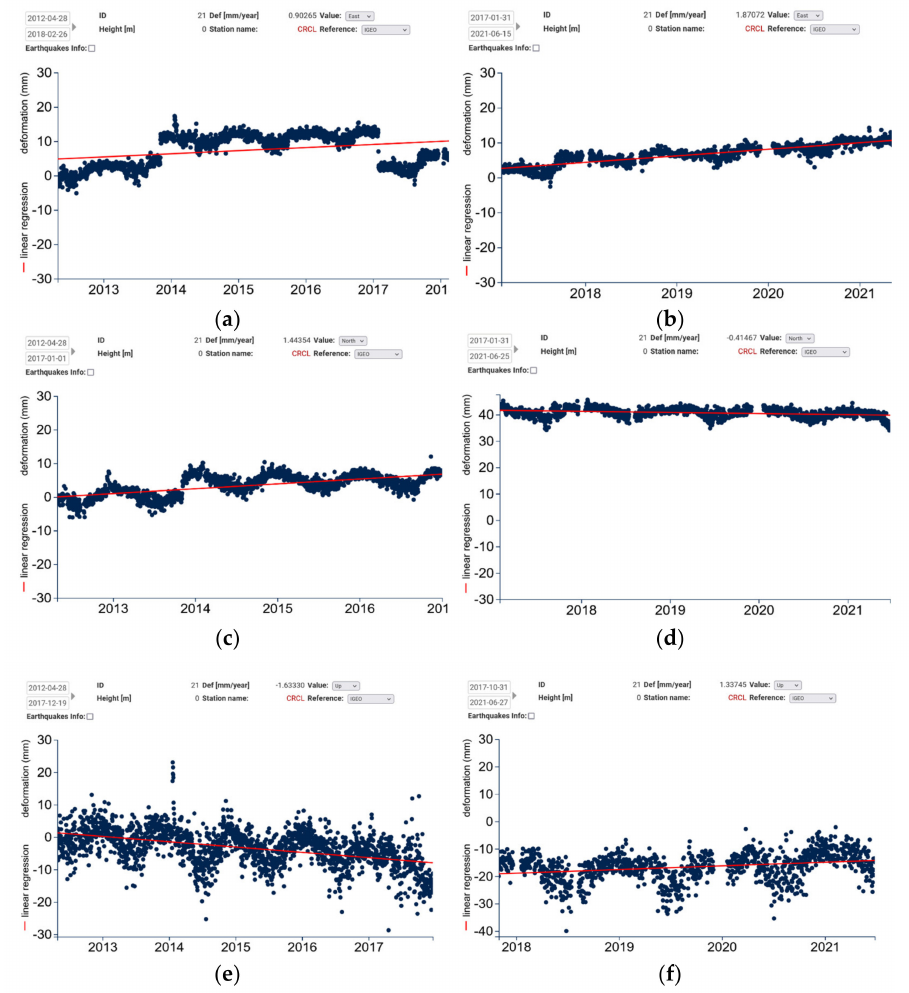
Figure 21. GNSS measured trend reversal at GNSS station CRCL: ( a ) 2012–2018 east, 0.9 mm/year; ( b ) 2017–2021 east, 1.9 mm/year; ( c ) 2012–2017 north,1.45 mm/year; ( d ) 2017–2021 north, − 0.41 mm/year; ( e ) 2012–2017 up, − 1.63 mm/year; ( f ) 2017–2021 up, 1.33